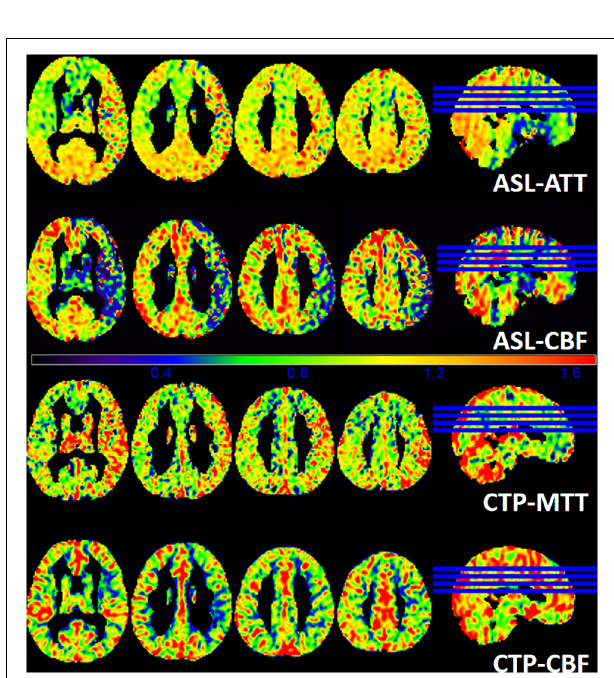
FIGURE 5 | A patient with 6 days of weakness in the right limb at admission. The images demonstrate the gray matter of ASL-ATT, ASL-CBF, CTP-MTT, and CTP-CBF. ASL shows hypoperfusion area of the left frontal, temporal and occipital lobes and basal ganglia. The ASL-CBF of the infarct regions decreases and the ASL-ATT increases compare to the contralateral side. CTP is in concordance with the result of